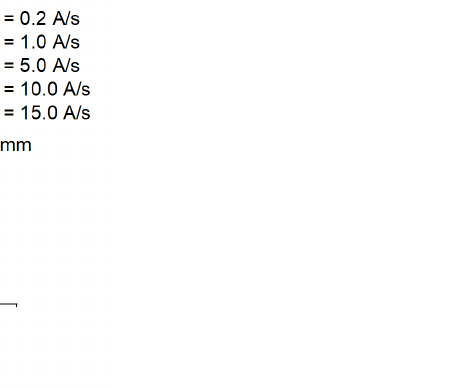
Figure 7. Dependences of the ME coupling coefficient on the electric polarization for different slew rates.